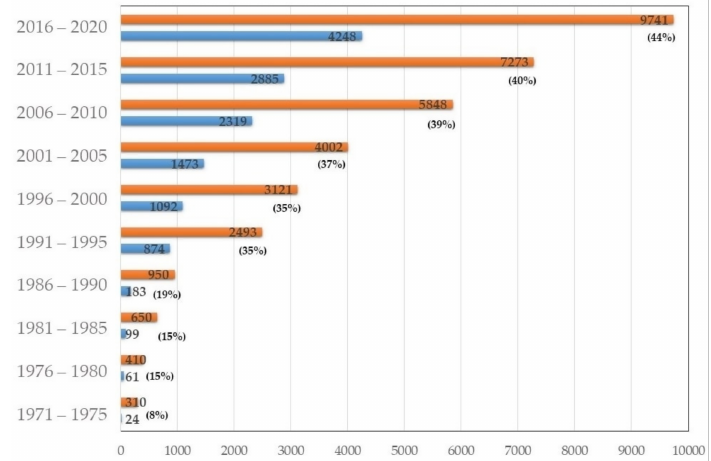
Figure 2. Relative weight of reports retrieved using the term “phthalocyanin*” (orange bars) vs. its refining with the term “photo*” (blue bars). In parentheses are the percentage weights of photo- applications over all